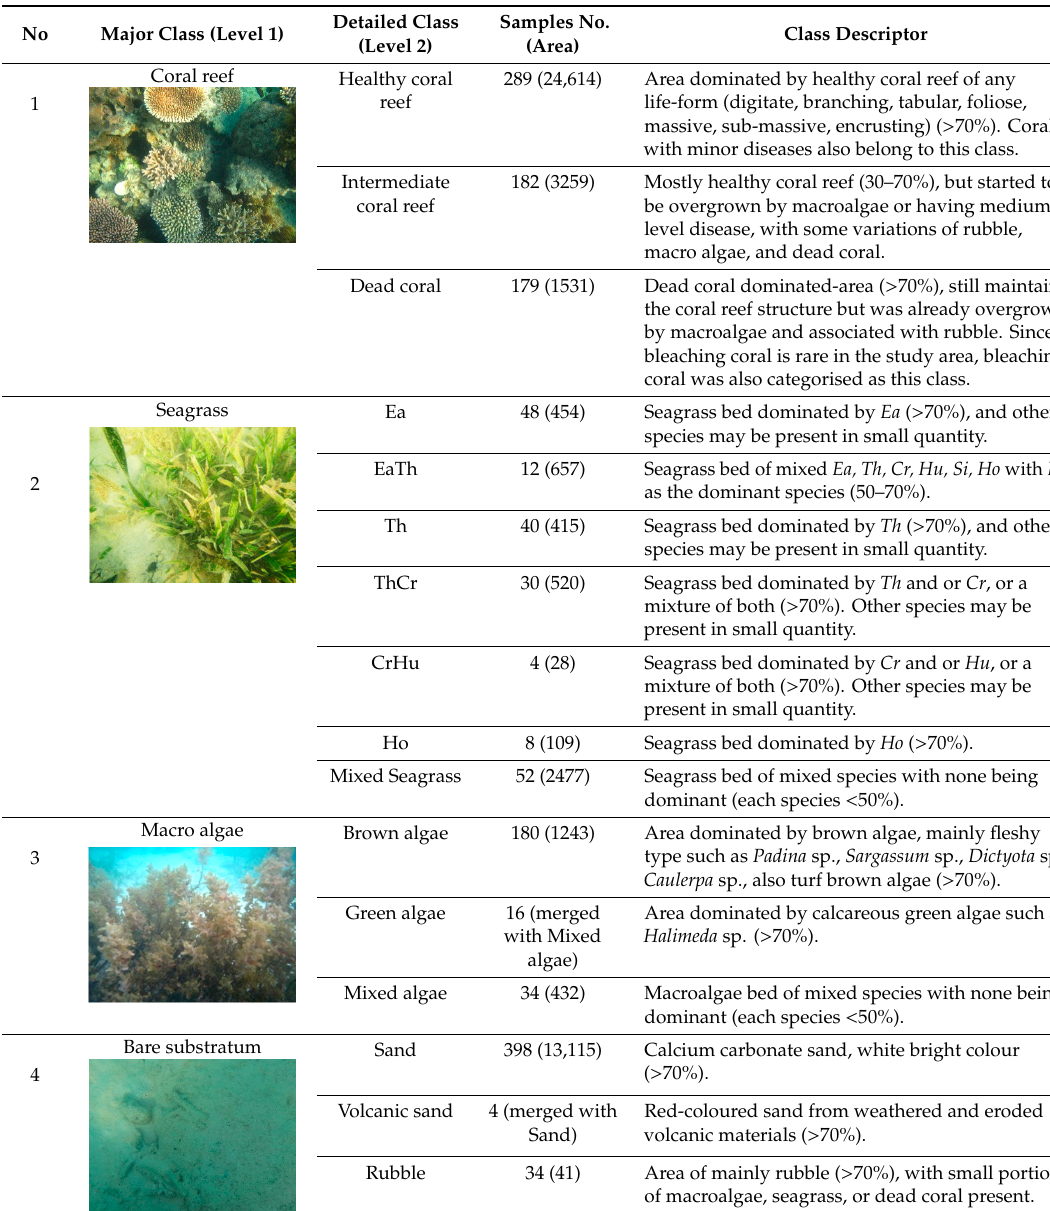
Table 3. The classification scheme of benthic habitats used in this research along with the number of samples. The numbers in bracket are the number of pixels obtained from the extrapolation of point samples into area samples based on image segmentation result resampled to WV2 pixel size (4 m 2 ).